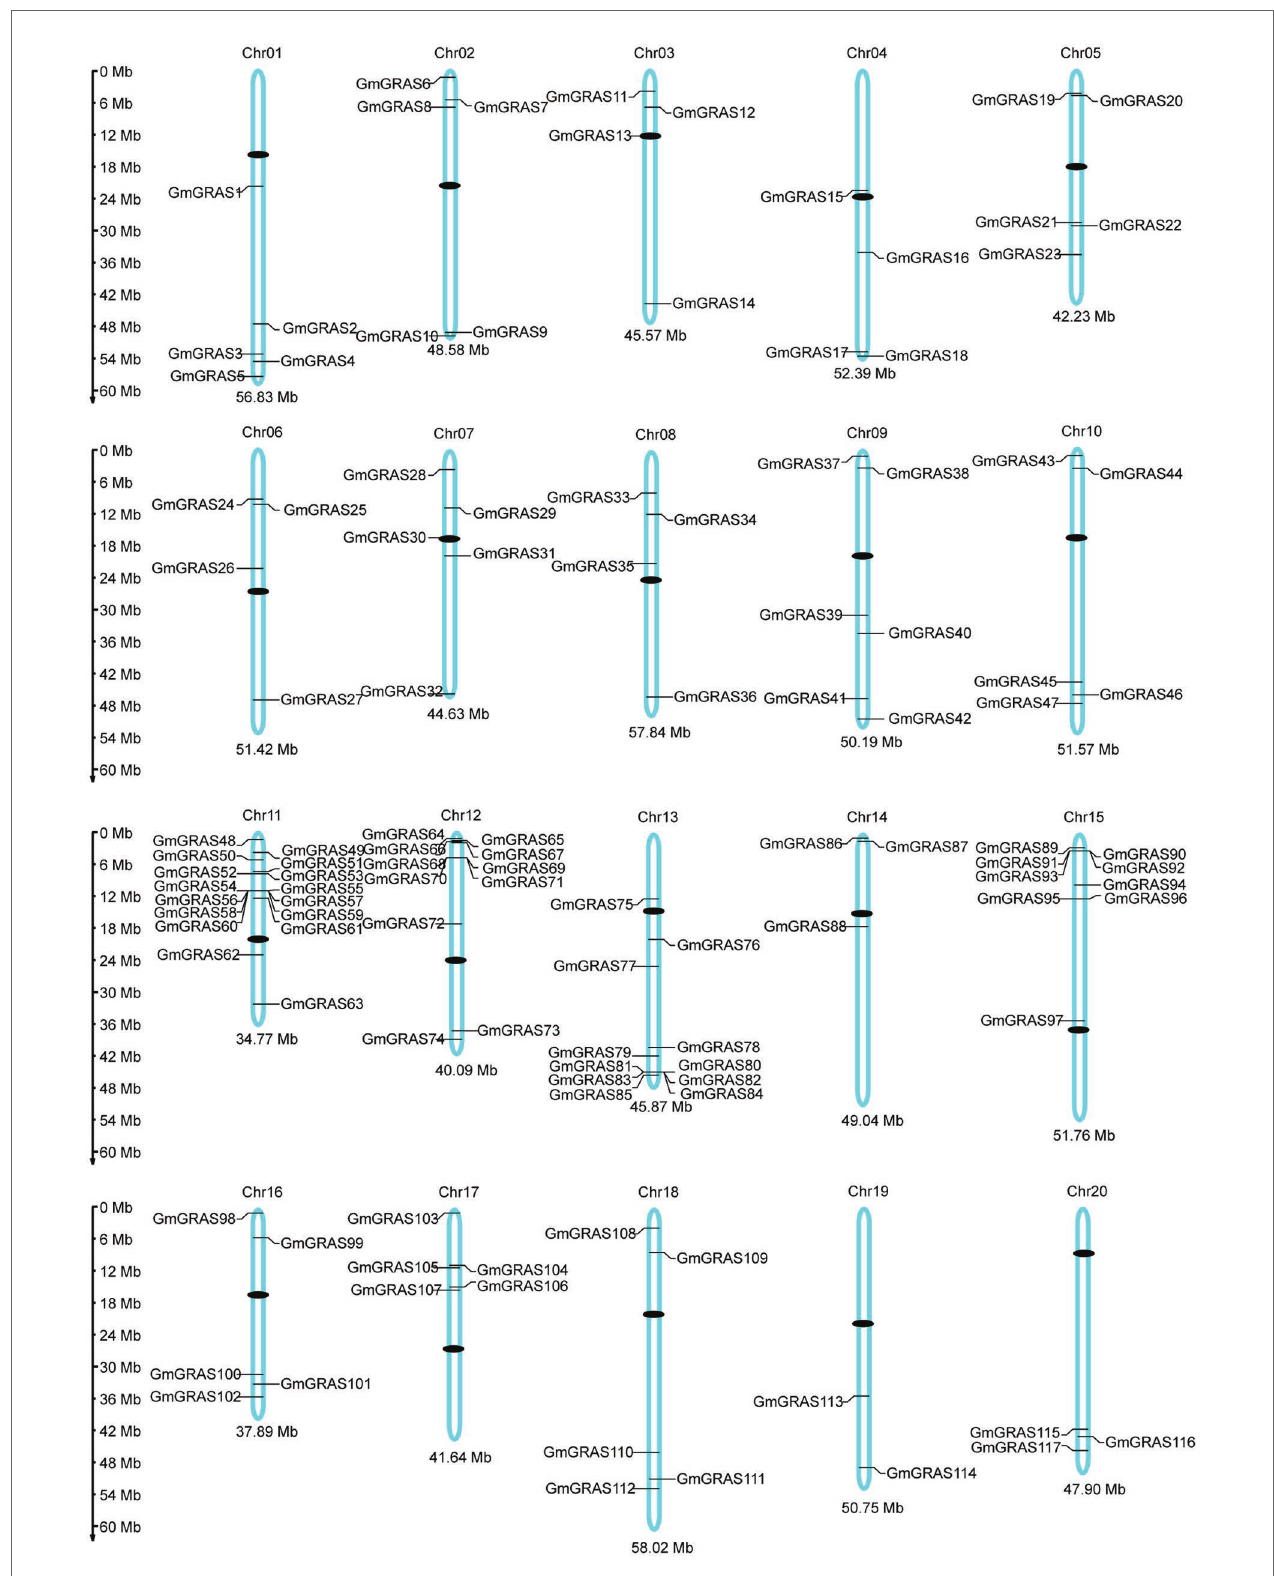
FIGURE 1 | Chromosomal distribution of 117 GRAS genes in soybean. The scale bar on the left indicates the size of the